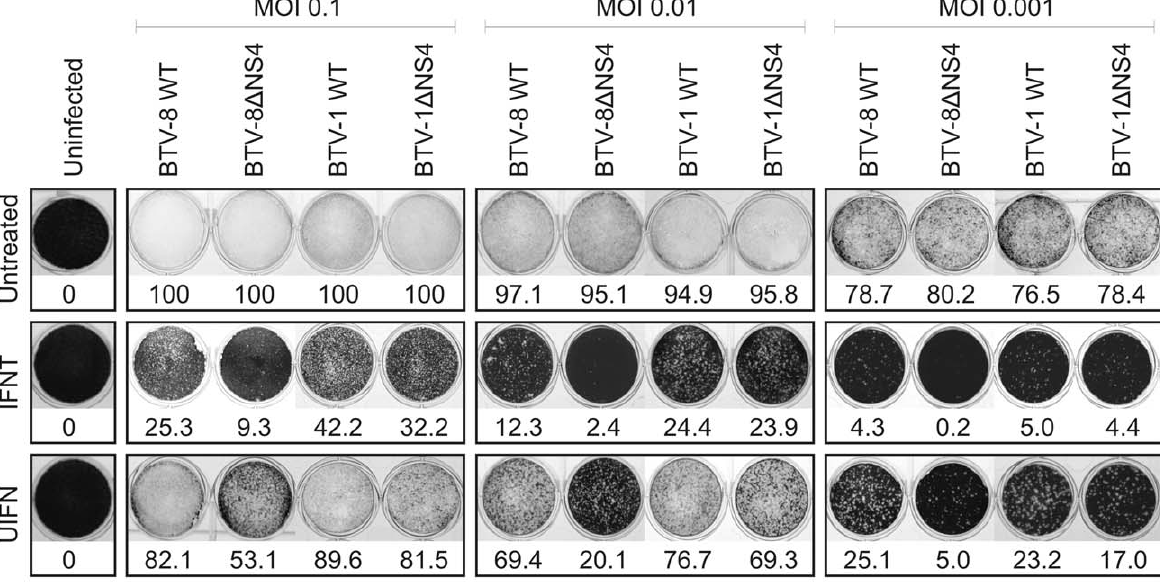
Figure 6. Cytopathic protection assay of CPT-Tert cells monolayer. CPT-Tert cells were treated or mock treated with 1000 AVU/ml of interferon ( Tau, IFNT or Universal, UIFN) for 20 h prior, and 2 h after, being infected by BTV-8 and BTV-1 (wt and D NS4) viruses at different MOIs (0.1, 0.01 and 0.001). Cell monolayers were stained at 72 h post-infection using crystal violet. Values indicated below each well correspond to the relative quantification (in percent) of the disrupted monolayer using Image-Pro Plus (MediaCybernetics, Inc.).